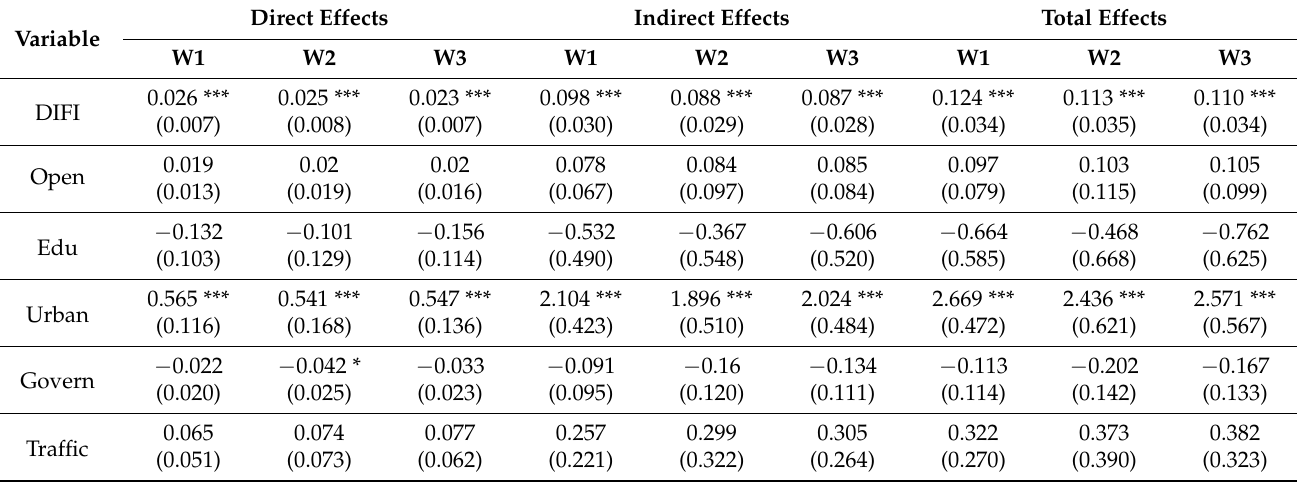
Table 7. Direct effects, indirect effects, and total effects of SAR